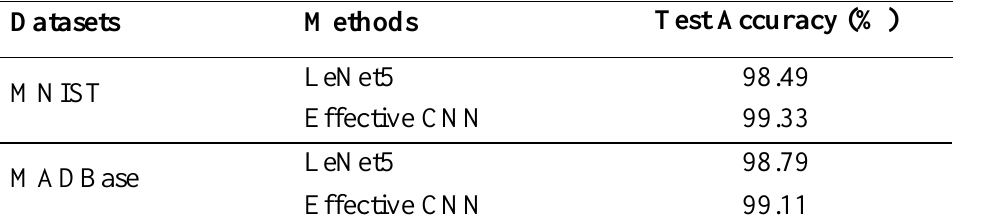
Table 3 . Classification results with DL (LeNet5 [5] and Effective CNN [17])